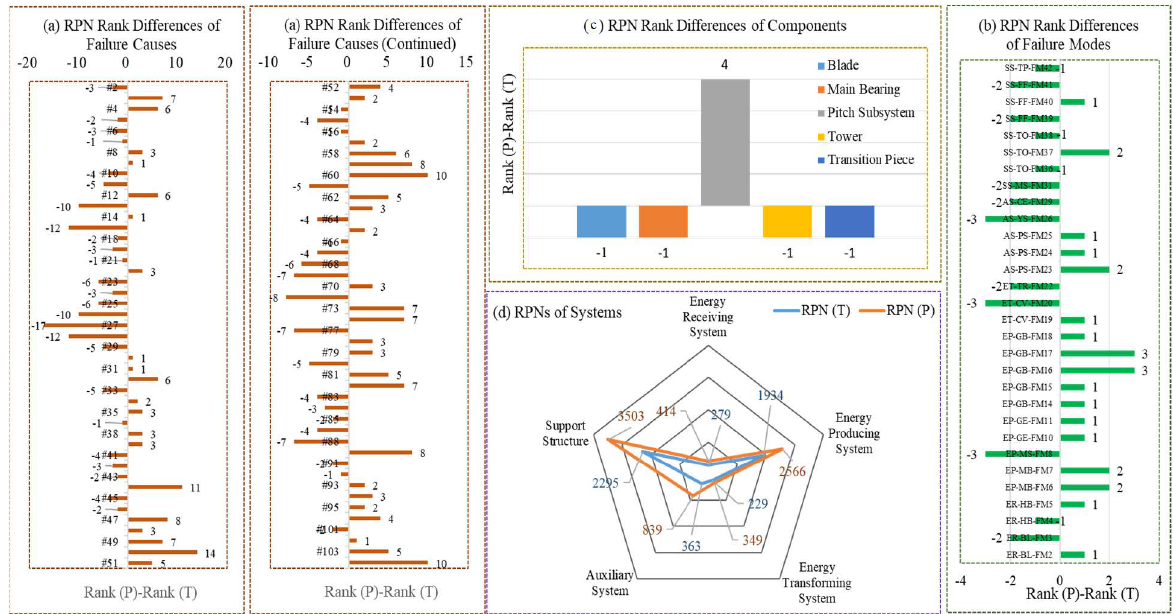
Figure 8. Comparison of results of proposed and conventional FMEAs/Rank (P): RPN rank com- puted by proposed FMEA; Rank (T): RPN rank calculated by traditional FMEA; Definition of items refers to Appendix A (#: Failure cause).